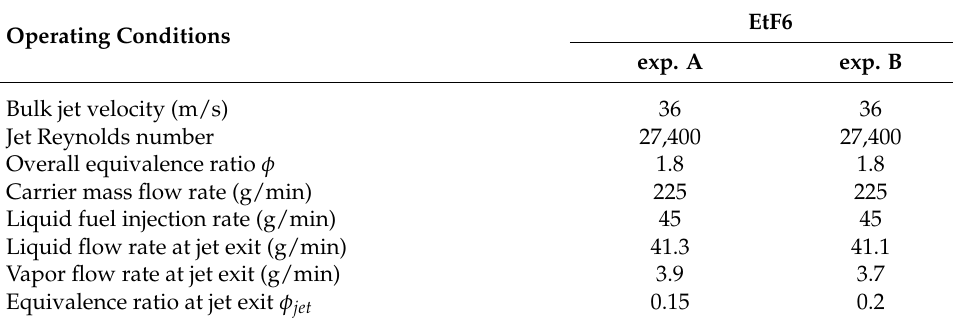
Table 1. Operating conditions for the investigated case